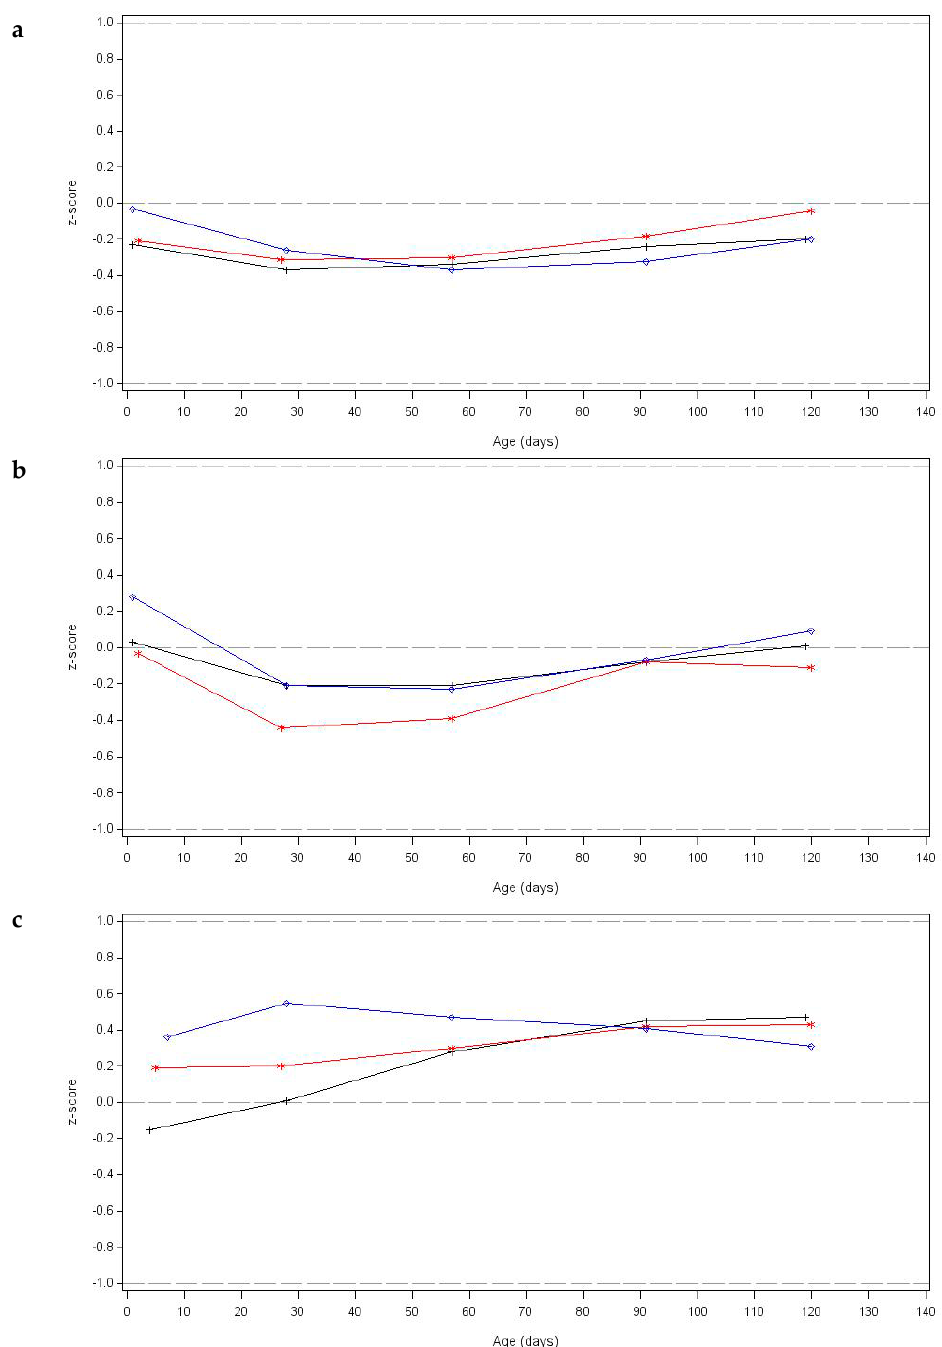
Figure 4. Mean weight-for-age ( a ), length-for-age ( b ) and head circumference-for-age ( c ) World Health Organisation (WHO) growth standard z-scores for the Control (red line), Experimental (blue line) and breastfed reference group (black line).